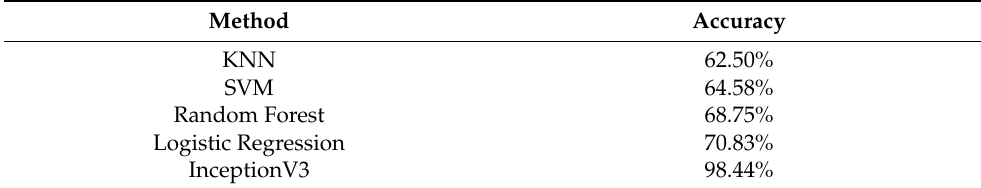
Table 8. Comparison of classification models’ accuracy.